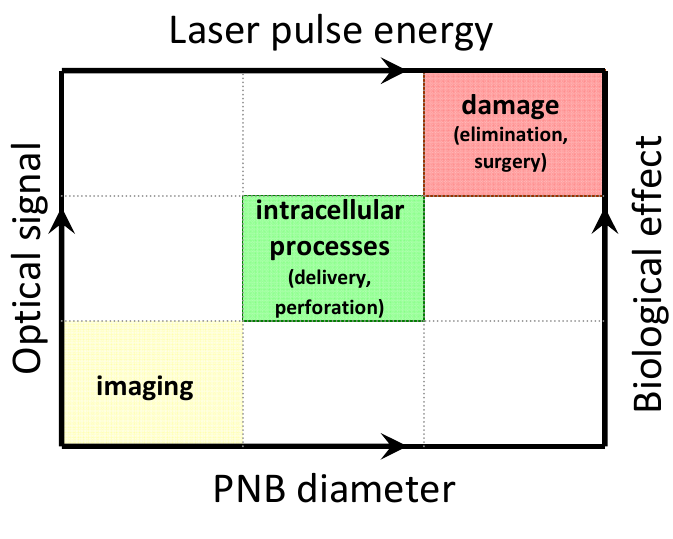
Figure 14. Tunability and guidance of the biological effects of PNBs: PNB diameter determines specific biological action and optical signal, while the pump pulse parameters determine the PNB